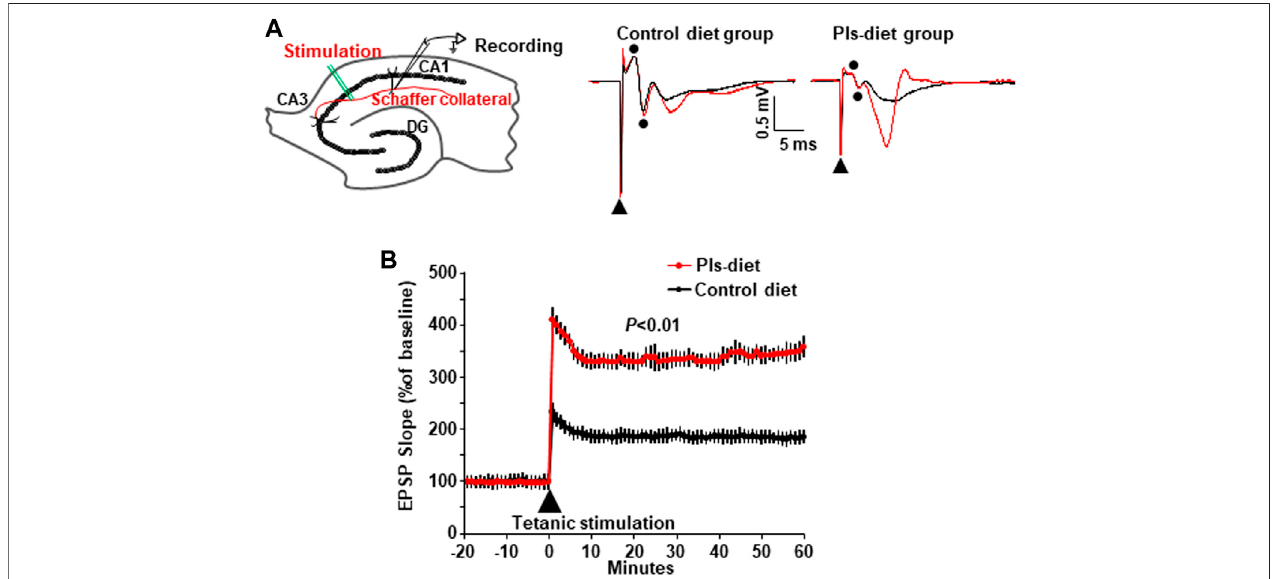
FIGURE4| EnhancementofsynapticplasticitybyPlsdiet. (A) The fi eldEPSPswereevokedbystimulationofSchaffercollateralsandrecordedinstratumradiatum in the mouse hippocampal slices (left panel). DG, dentate gyrus. The superimposed traces show the EPSP fi eld potentials at time − 10 min (black) and 60 min (red) in control and Pls diet mice (middle and right panels). In the traces of control diet [ (A) , middle], the biphasic wave (dots) just after the stimulus artifact (triangle) was considered to be a fi ber volley recorded from nerve fi bers since the amplitude was not affected by stimulation (black and red). Then the next downward wave was the fi rstEPSP.The small fi ber volleywasalso observed inthePlsdiet. (B) Percentchangesinthe fi eld EPSPsofPlsdietmice ( n =15)show asigni fi cantenhancement of LTP after the tetanus stimuli compared with the control slices ( n = 12). The data represent fi ve mice in each group and three to four slices from each mouse were examined). The data represent mean ± S.E.M., n = 5 in each group. **, p < 0.01 (Student ’ s